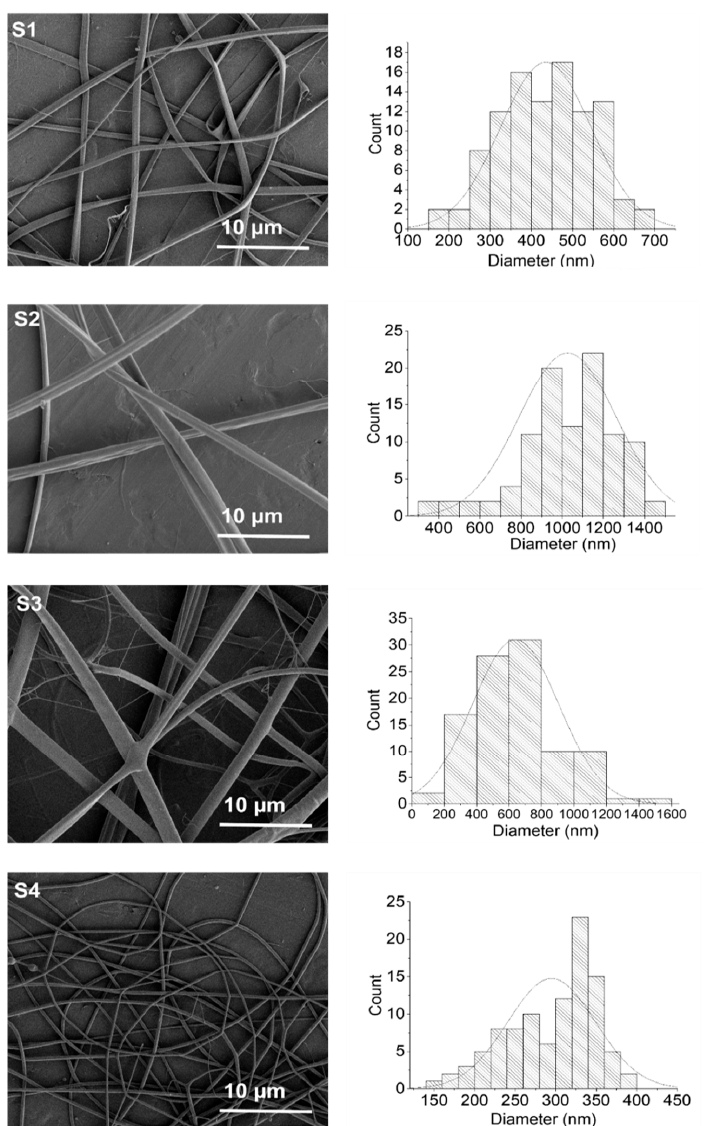
Figure 1. Scanning electron microscope (SEM) images of Ch/P fibers and respective histograms (on the right side) with the distribution of fiber diameters.